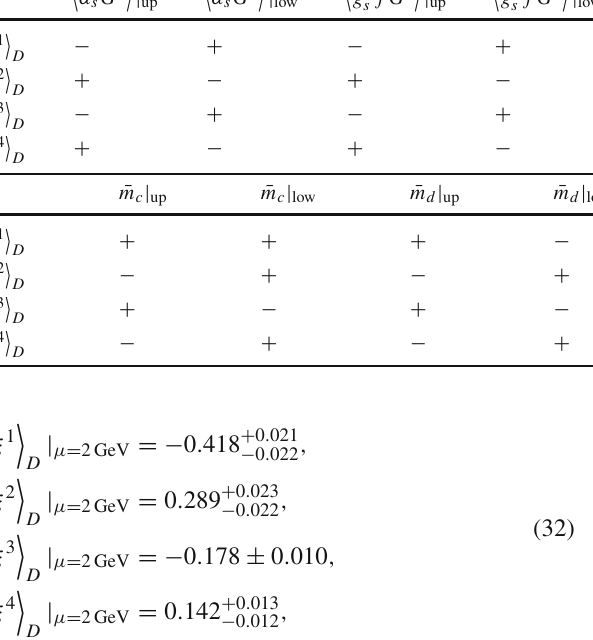
represent the positive and negative errors brought by the corresponding input, respectively